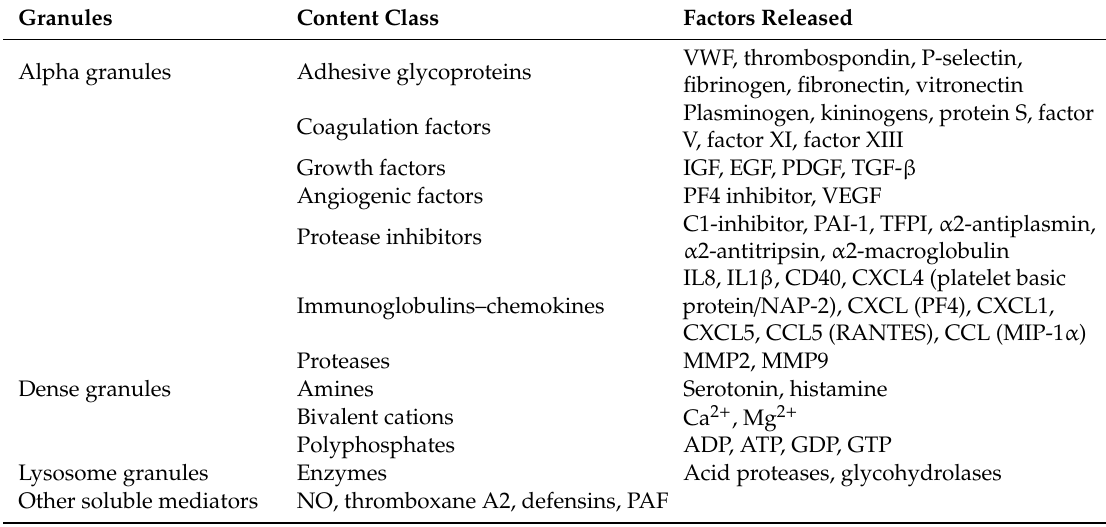
Table 1. Types of platelet storage granules and factors they release (adapted with permission